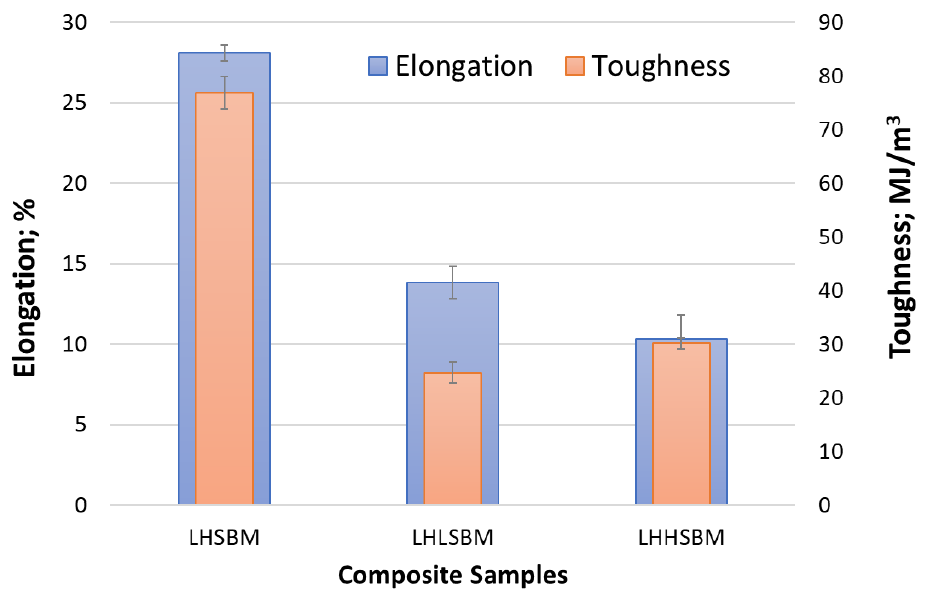
Figure 14. Elongation and toughness of the Al/SiC composites with different production scenarios.